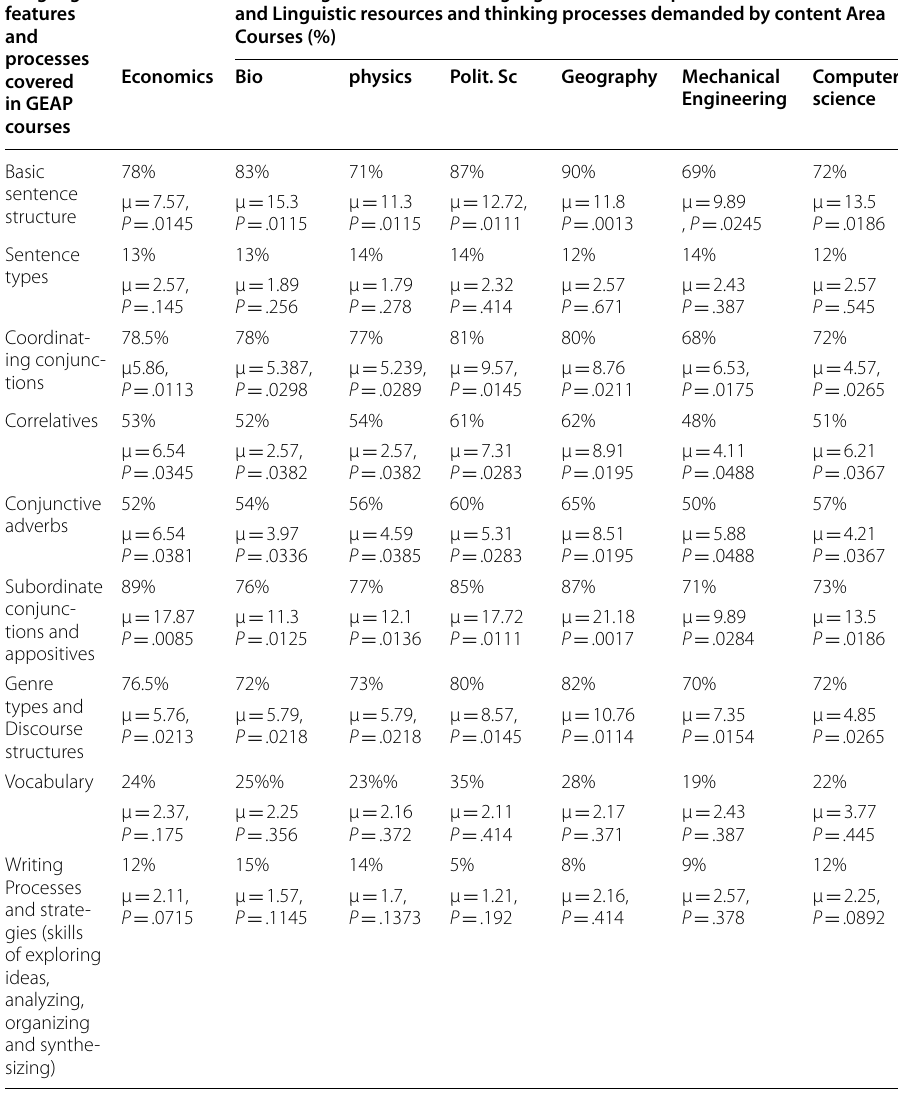
Table 2 Level of Alignment between Contents of EGAP Course and Demands of Content area Writing